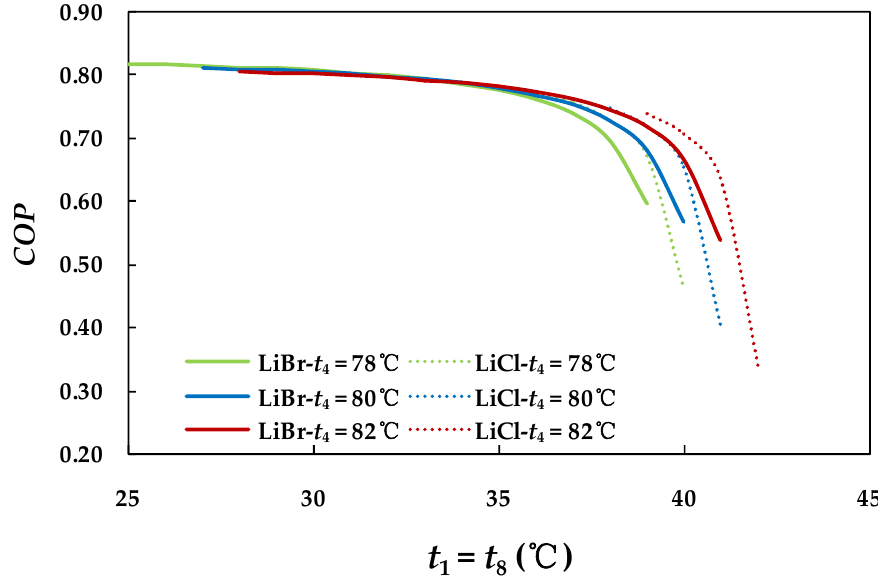
Figure 5. Condenser and absorber temperatures impact on the COP of the absorption system under various generator temperature levels (78 °C, 80 °C, and 82 °C) for the two working pairs ( t 10 = 7 °C, ε = 0.7).